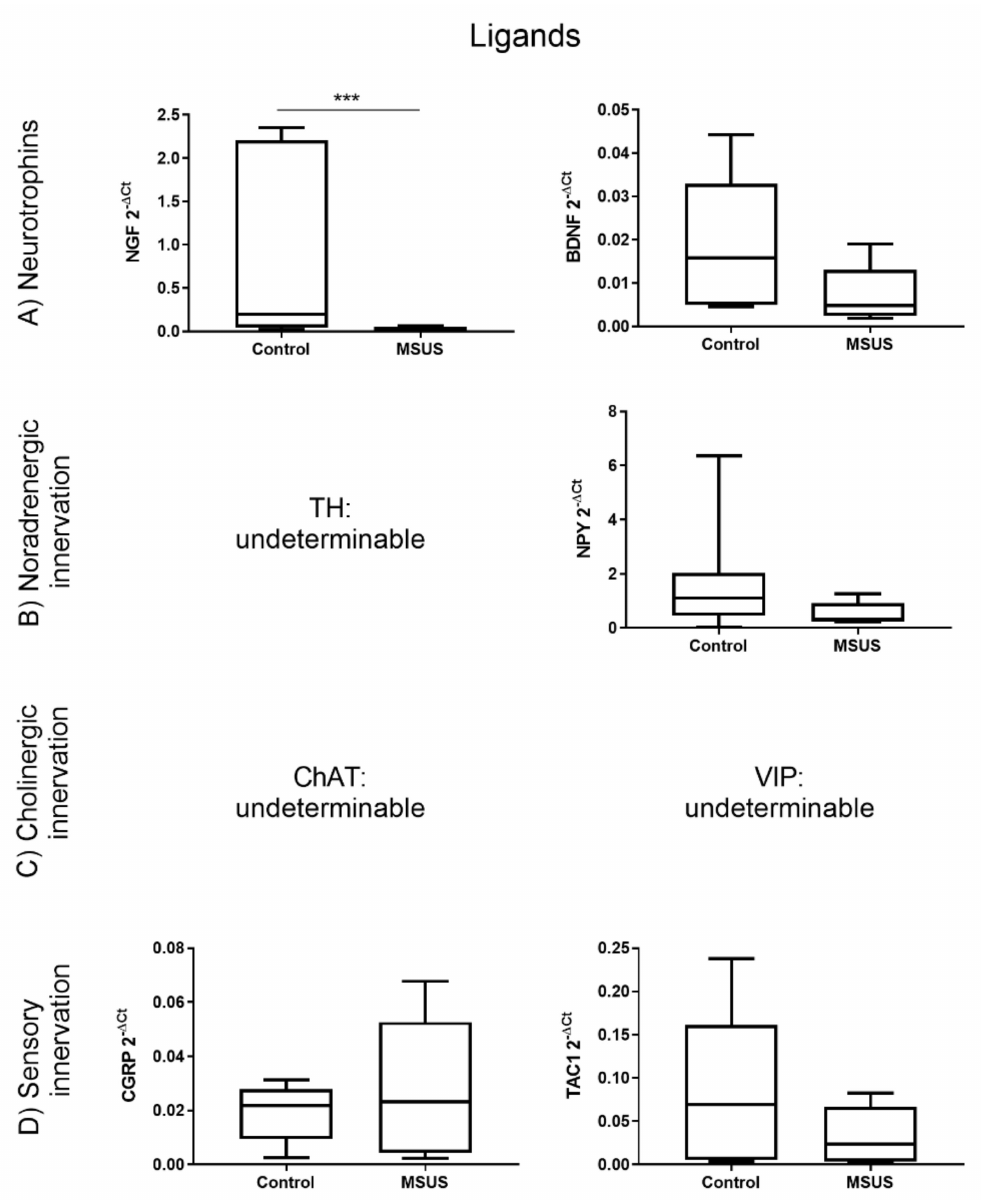
Figure 2. Di ff erential gene expression of neuronal ligands in bone between control and MSUS mice. Shown are the gene expression of neurotrophins ( A ), noradrenergic ligands ( B ), cholinergic ligands ( C ) and ligands involved in sensory innervation ( D ). Data ( n = 8 per group) are expressed as Min to Max of 2 − dCt . Significance level: *** p < 0.001 between indicated